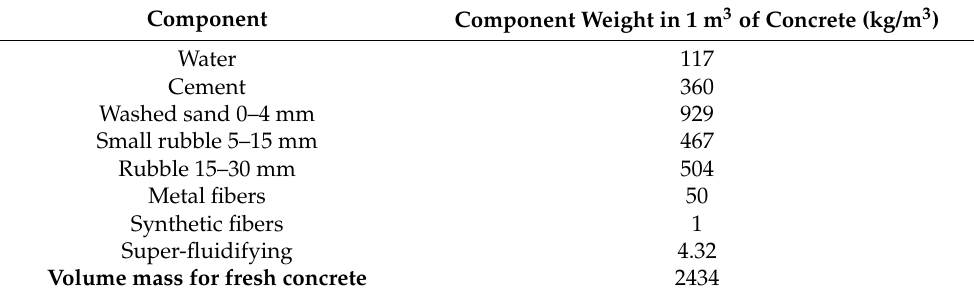
Table 3. Base concrete mix